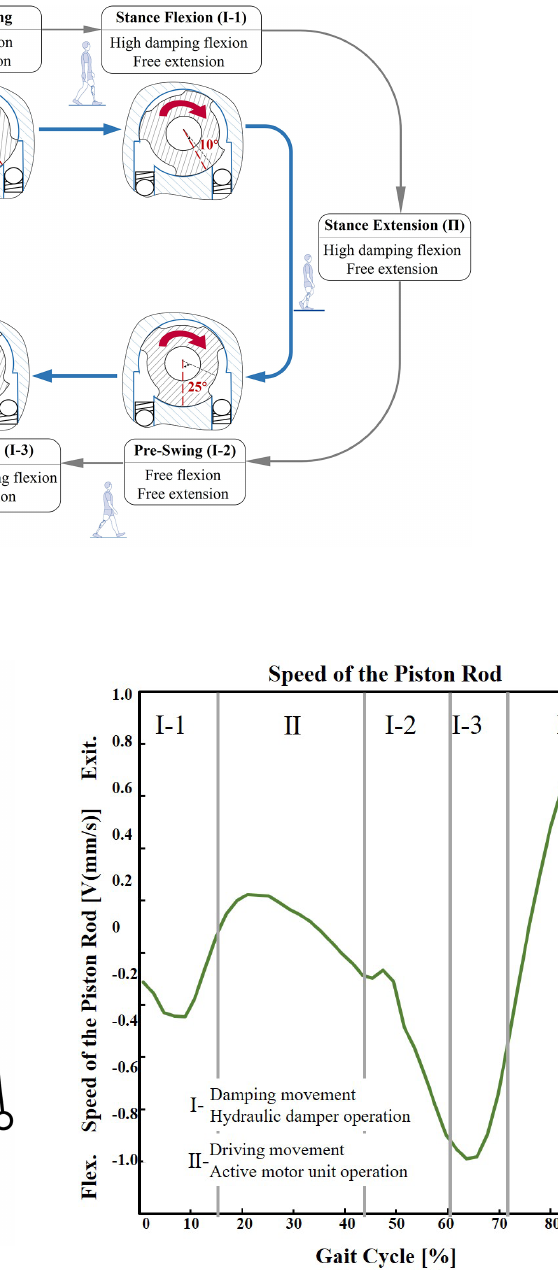
Figure 9. Speed of the piston